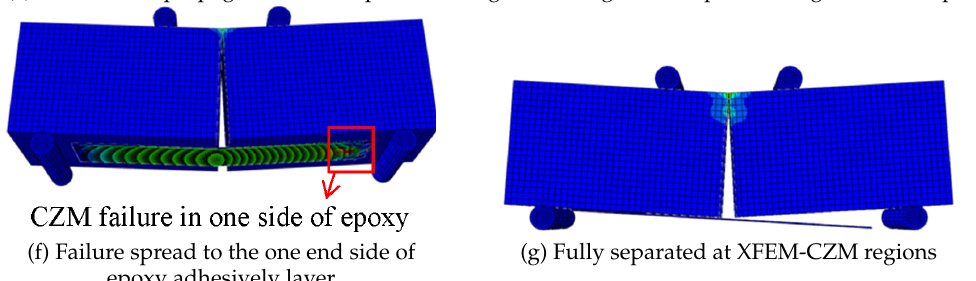
Fig. 13. Stress distribution of the adhesive layer along with the CFRP-concrete interface at a certain given load/displacement as labelled in Fig. 12 (beam series